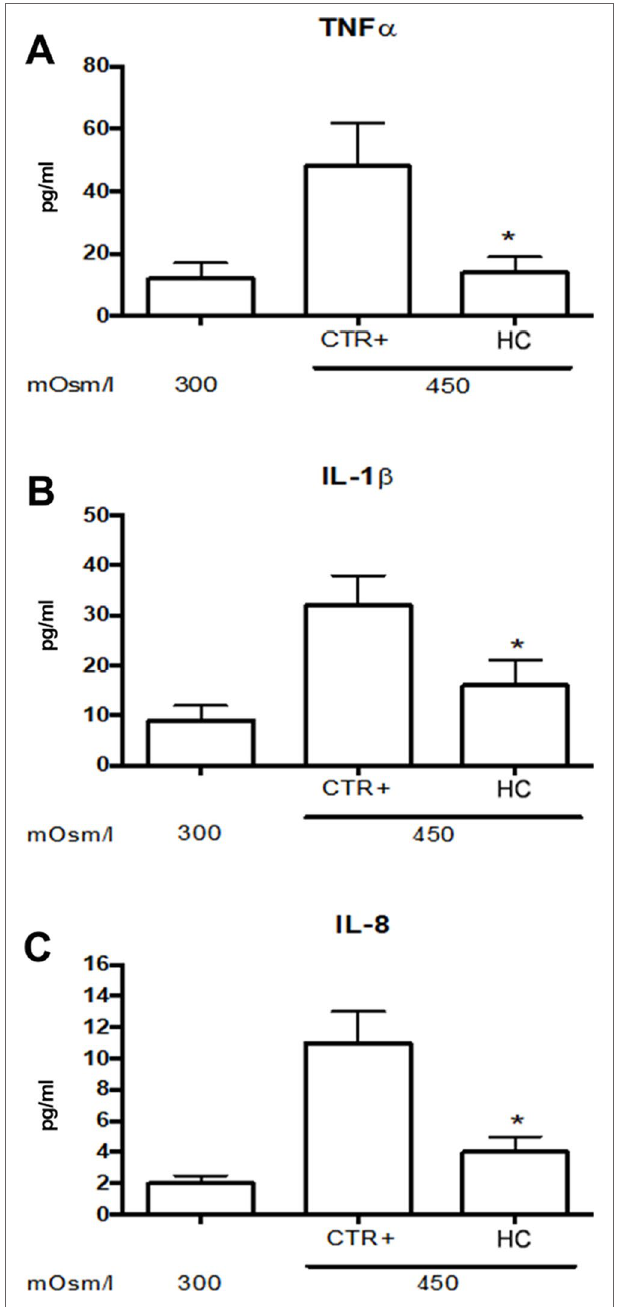
FIGURE 1 | Inflammatory cytokine levels in SIRCs exposed to hyperosmotic stress. (A) TNF α (B) IL-1 β and (C) IL-8 levels.*p < 0.05 HC treatment vs. Ctrl+ (SIRCs with hyperosmotic insult); SIRCs, rabbit corneal epithelial cells; HC, hydrocortisone; n =